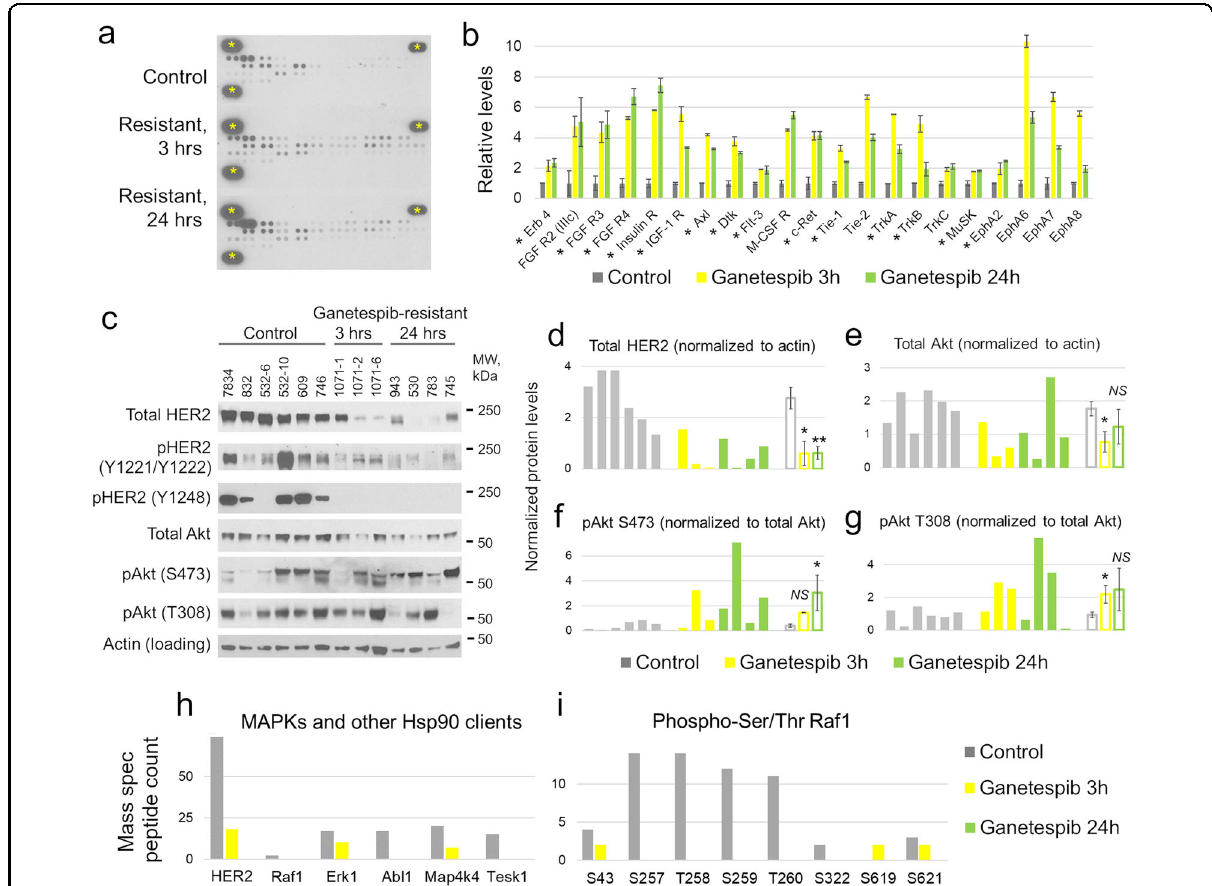
Fig. 3 Activation of receptor tyrosine kinases (RTKs) and Akt/phospho-Akt in Ganetespib-resistant Neu tumors. a , b Phospho-kinome assay. a Representative immunoblots; yellow asterisks, reference markers. b Quanti fi cation of individual p-RTKs. Only the p-RTKs signi fi cantly upregulated at both timepoints (3 h, 24 h) in Ganetespib-resistant vs. Control samples are shown, i.e., 21 out of 39 p-RTKs. Mean ± SD of two technical replicas. Asterisks, the RTKs known as Hsp90 clients. c – g Western blots with the indicated antibodies ( c ) and their quanti fi cation by densitometry normalized as indicated ( d – g ). While HER2 is destabilized in Ganetespib-resistant tumors ( c , d ), its effector Akt is not ( c , e ) and is activated at two different phosphorylation sites, Ser 473 and Thr 308 ( c , f , g ). Empty bars are mean ± SEM of the tumors in each group. * p < 0.05, ** p < 0.01, NS , not signi fi cant, unpaired two-tailed Student ’ s t -test. h , i Protein levels of HER2, its effectors Raf1, Erk1, and other known Hsp90 clients ( h ), and phospho-Ser/Thr Raf1 ( i ) by mass spectrometry. Note that the protein levels of HER2, Raf1, Erk1, p-Raf1 and known Hsp90 clients are all downregulated at both, 3 h and 24 h